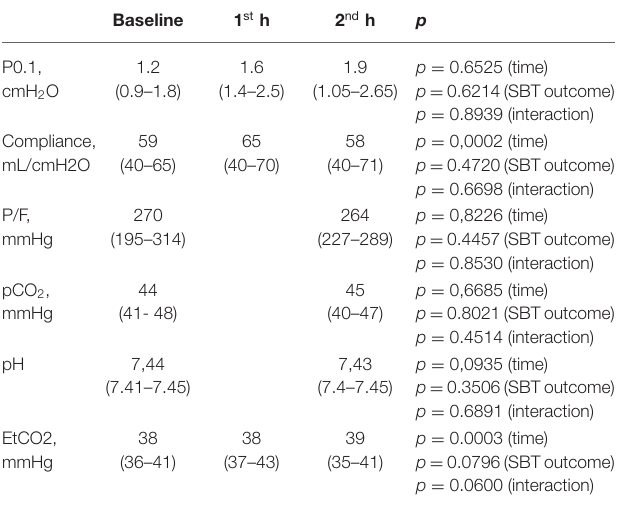
TABLE 3 | Respiratory variables at three time points in the whole